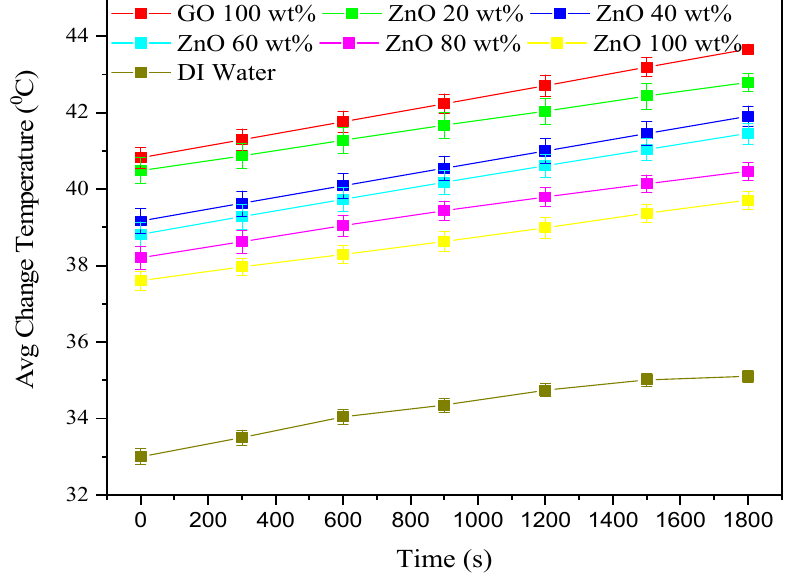
Figure 7. Average change temperature profile of DI water base binary CuO–GO nanofluids at 0.0004 wt % concentration.